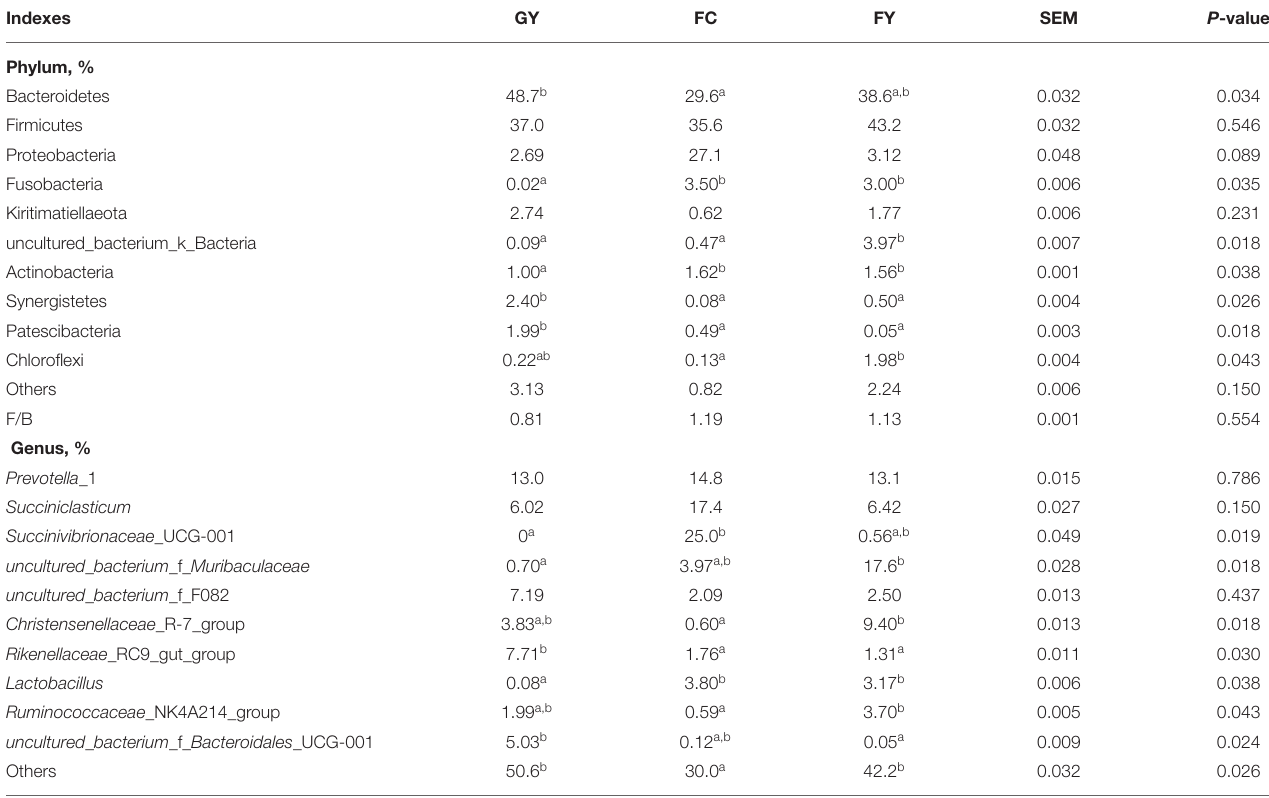
TABLE 4 | Relative abundance of ruminal bacterial communities at phylum and genus levels of GYs, FC, and FYs.